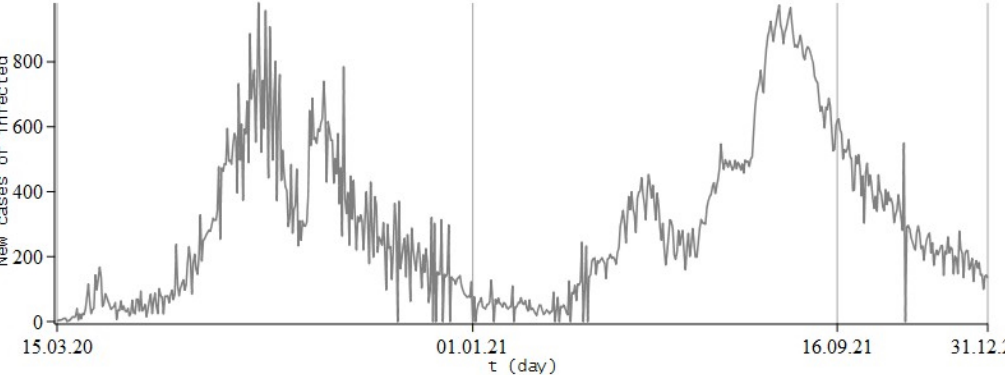
Figure 14. Experimental data: for new cases of COVID-19 infection in the Republic of